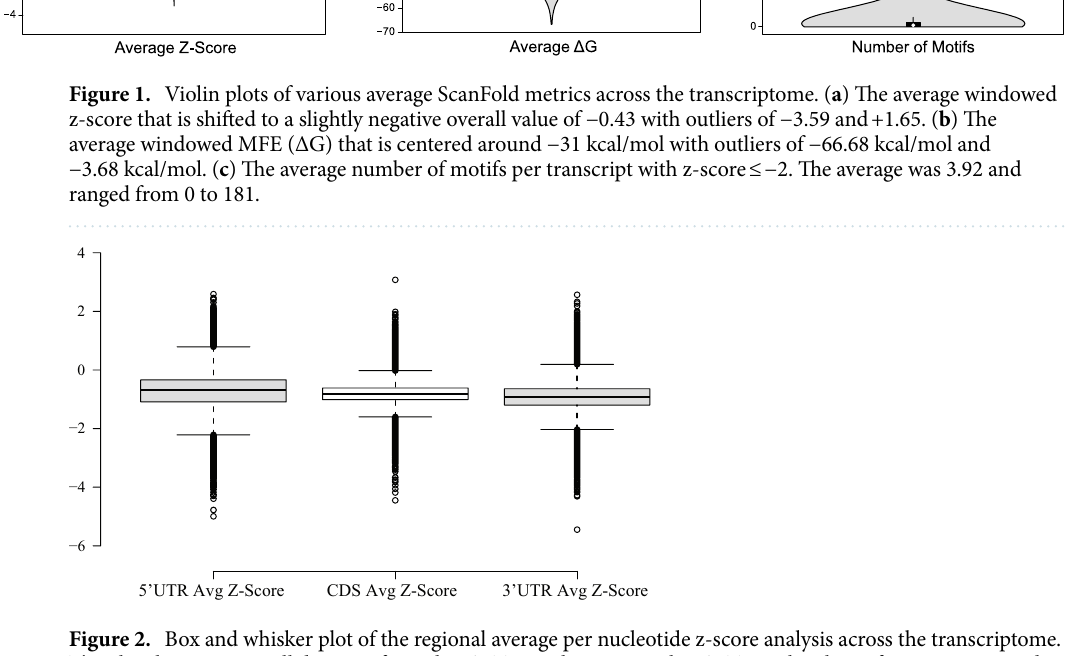
Figure 2. Box and whisker plot of the regional average per nucleotide z-score analysis across the transcriptome. The plot shows an overall decrease from the 5 ′ UTR, to the CDS, to the 3 ′ UTR with values of −0.71, −0.82, and −0.92,